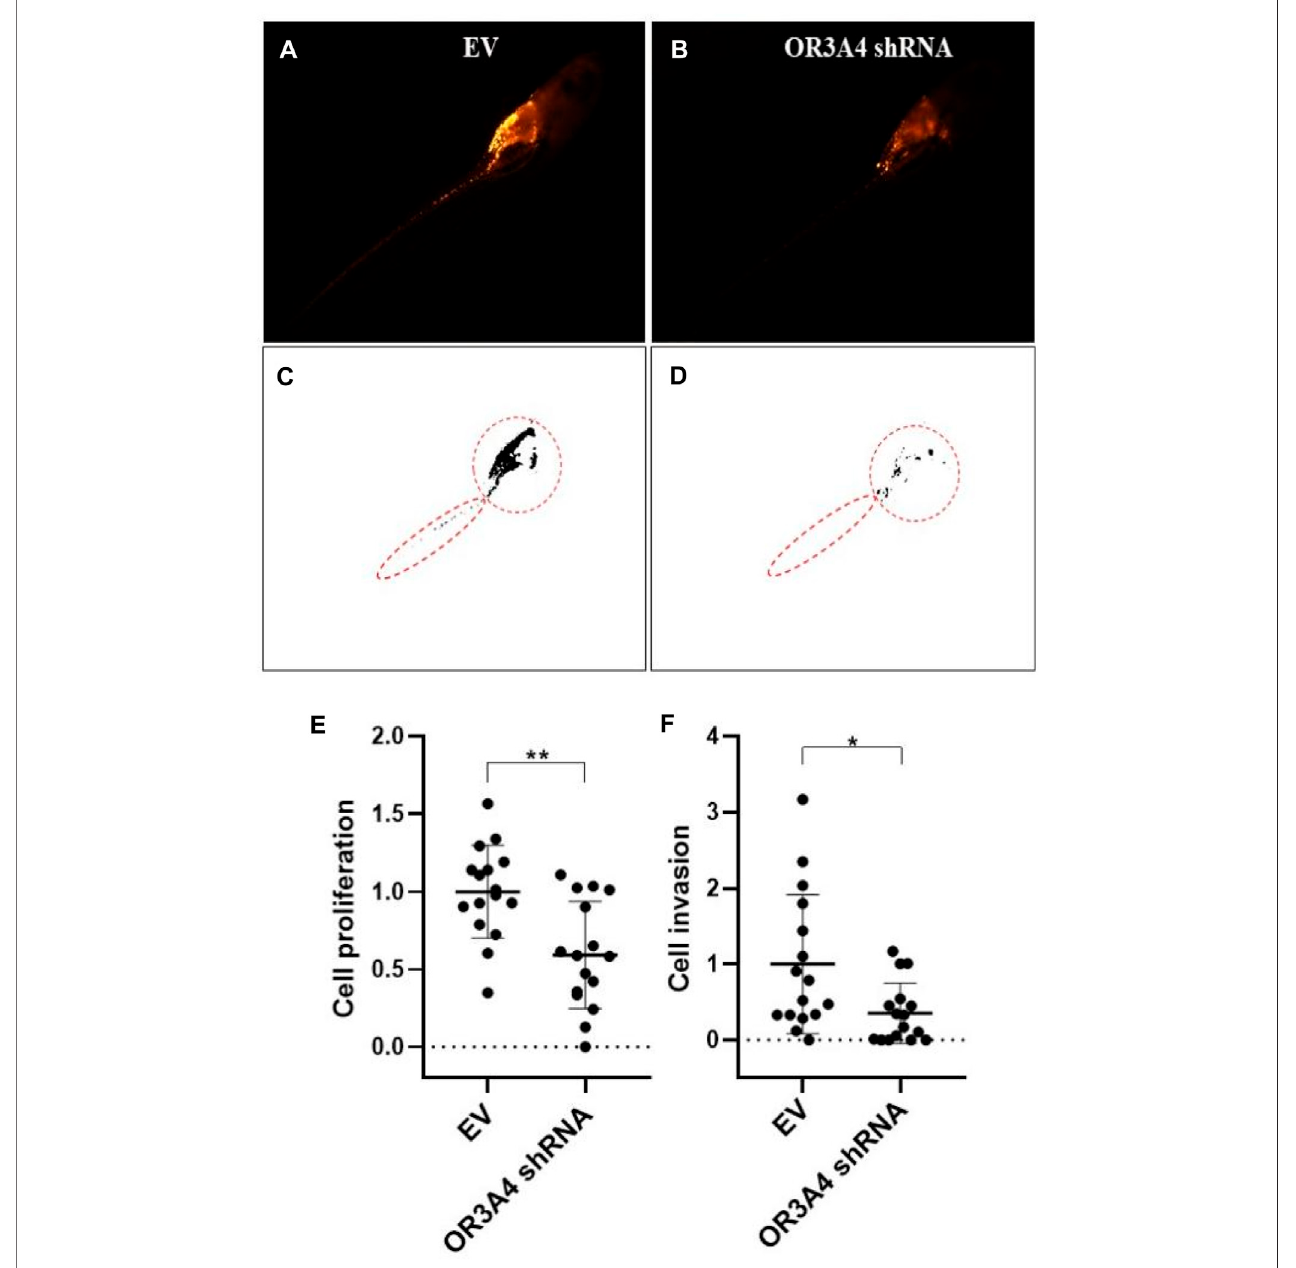
FIGURE 2 | Knocked out of lncRNA OR3A4 in the zebra fi sh xenograft model resulted in decreased proliferation and migration of SKOV3 (A, B) Representative fl uoroscopy image at 4 days after transplantation of the empty vector (EV) transfected with shRNA and the SKOV3 cells transfected with the lncRNA OR3A4 shRNA plasmid into the protriptyline space of zebra fi sh larvae at 3d after fertilization (C, D) Fluorescent segment images corresponding to those pictures. The signals in the circles(transplantsites)areemployed tothestatisticalanalysisofcellproliferation,and thesignals intheovalcircles(migratedtrunksites)areused forthestatistical analysis of cell migration (E, F) Statistical analysis of the effects of transfection of OR3A4 shRNA plasmid on the proliferation and migration of SKOV3 in the zebra fi sh xenograft model. * p < 0.05, ** p < 0.01, n (cid:2) 16.